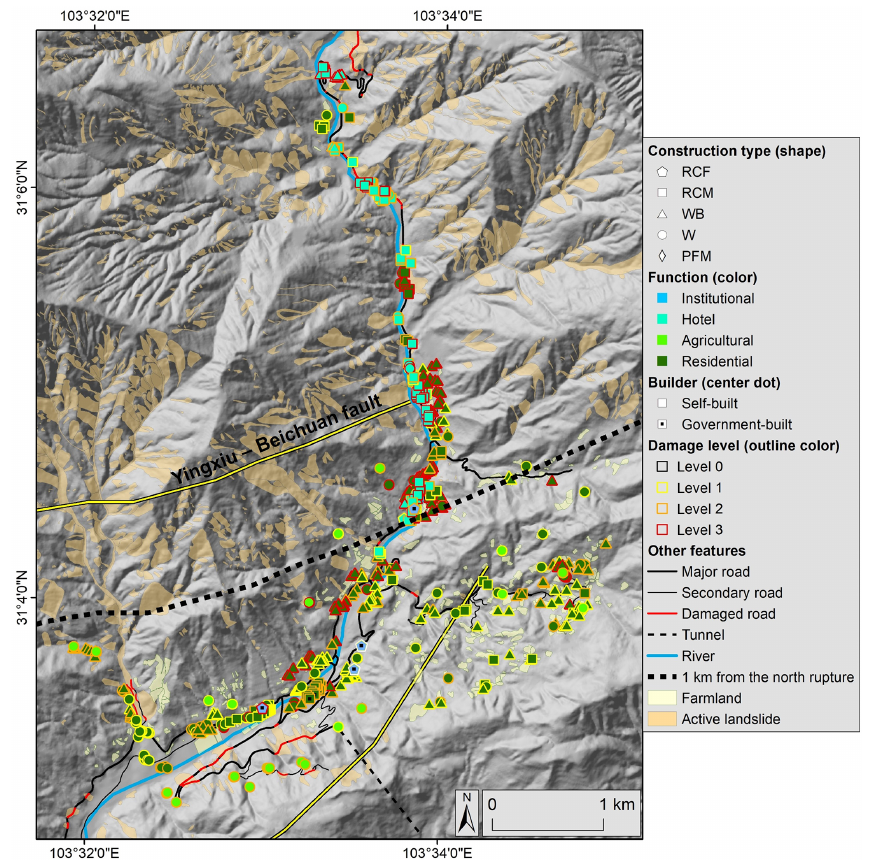
Figure 3. A map showing the damage level of buildings and the distribution of coseismic landslides after the 2008 Wenchuan earthquake. Buildings on the foot wall (southeast) and 1km away from the northern fault rupture (indicated by the thick dotted line) suffered significantly less damage. Table 4. Statistics of building damage caused by the earthquake. The percentage in the parentheses was calculated by the number in the cell divided by the total numbers of the row. ∗ Sum of all affected